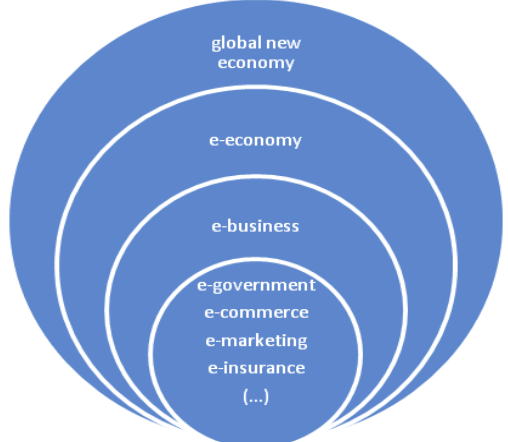
Figure 1. The divisions within the new economy Source: J. Papi ń ska-Kacperek, 2008, p.